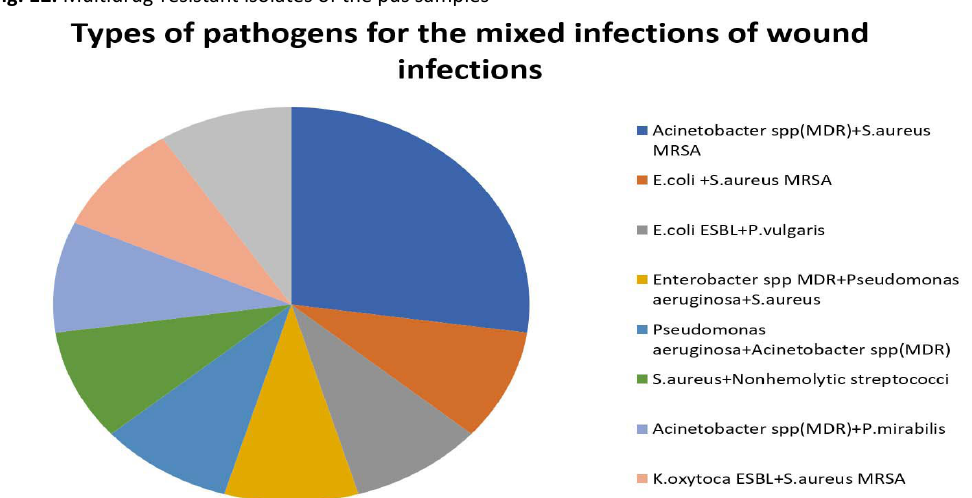
Fig. 13. Types of pathogen combinations for the mixed wound